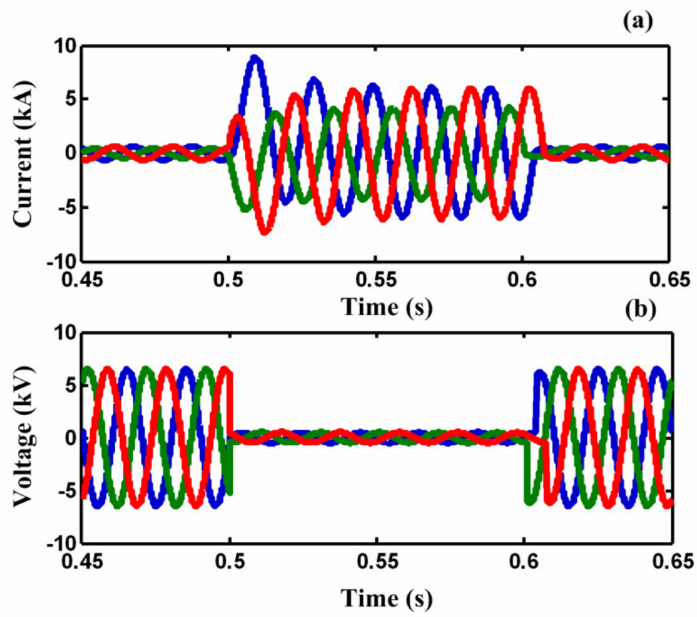
Figure 8. ( a ) Fault current in case A, ( b ) voltage of PCC in case A.